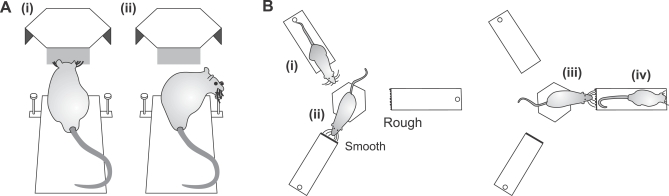
Texture Discrimination TasksTrials sketched from camera images.(A) The 1-arm task. (i) The rat perched on the edge of the platform and extended to touch the rough texture (gray rectangle) with its whiskers. (ii) Having identified the texture, the rat turned to the right drinking spout and received a water reward.(B) The 3-arm task. (i) The rat began by crossing from the start arm to the central platform, (ii) touched the smooth-textured discriminandum with its whiskers, (iii) rejected the first texture and proceeded to touch the rough-textured discriminandum, and (iv) crossed the gap to collect a water reward at the distant part of the arm.